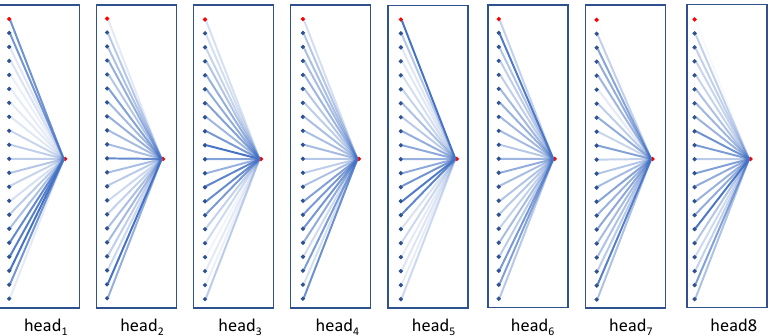
Figure 9. Visualization of the attention responses in the last TRU block in the ST-RT